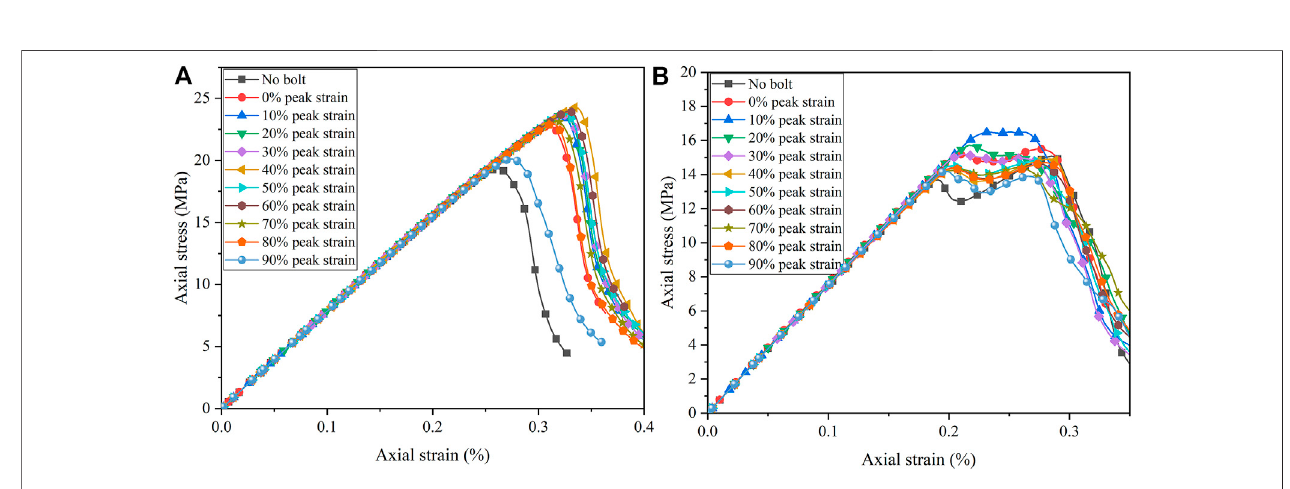
FIGURE 13 | Stress – strain curves of bolted jointed specimens under different bolt installation opportunities for joint angles of 75 ° (A) and 45 ° (B) .